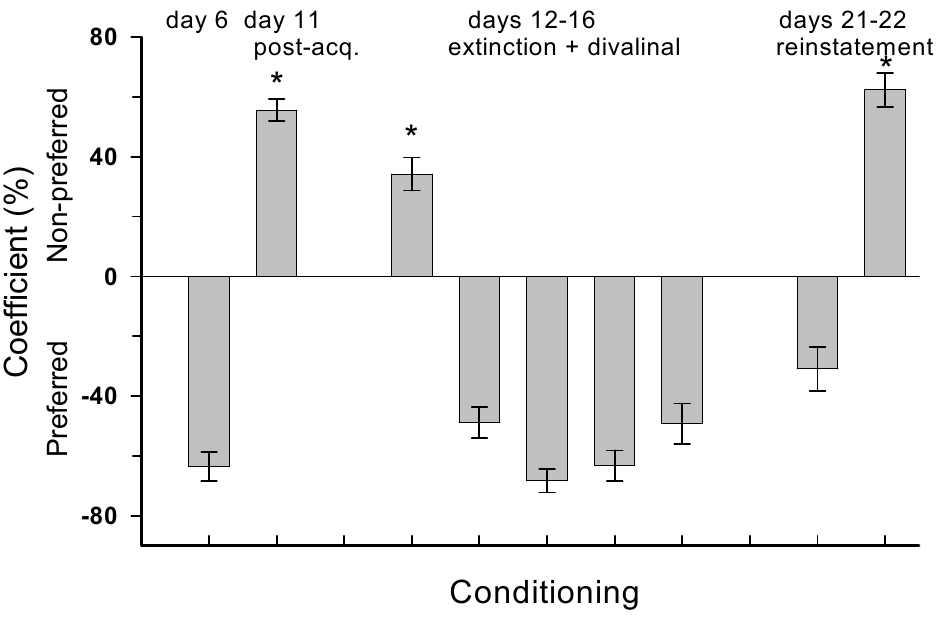
Figure 4. Mean ± SEM percent time spent in the designated compartment. Following acquisition trials to MA (days 7–10) the animals demonstrated a shift from the preferred (day 6) to the nonpreferred (day 11) compartment. During extinction trials (days 12–16) the animals received icv infusions of divalinal 5-min prior to access to both compartments for 30 min on each day and evidenced a shift back to the preferred compartment. On days 17–20 the rats were rested in their home cages. On days 21 and 22 each rat received MA followed 5-min later with access to both compartments. During these two days there was a clear shift back in favor of the nonpreferred compartment indicating reinstatement of dependence. * p <